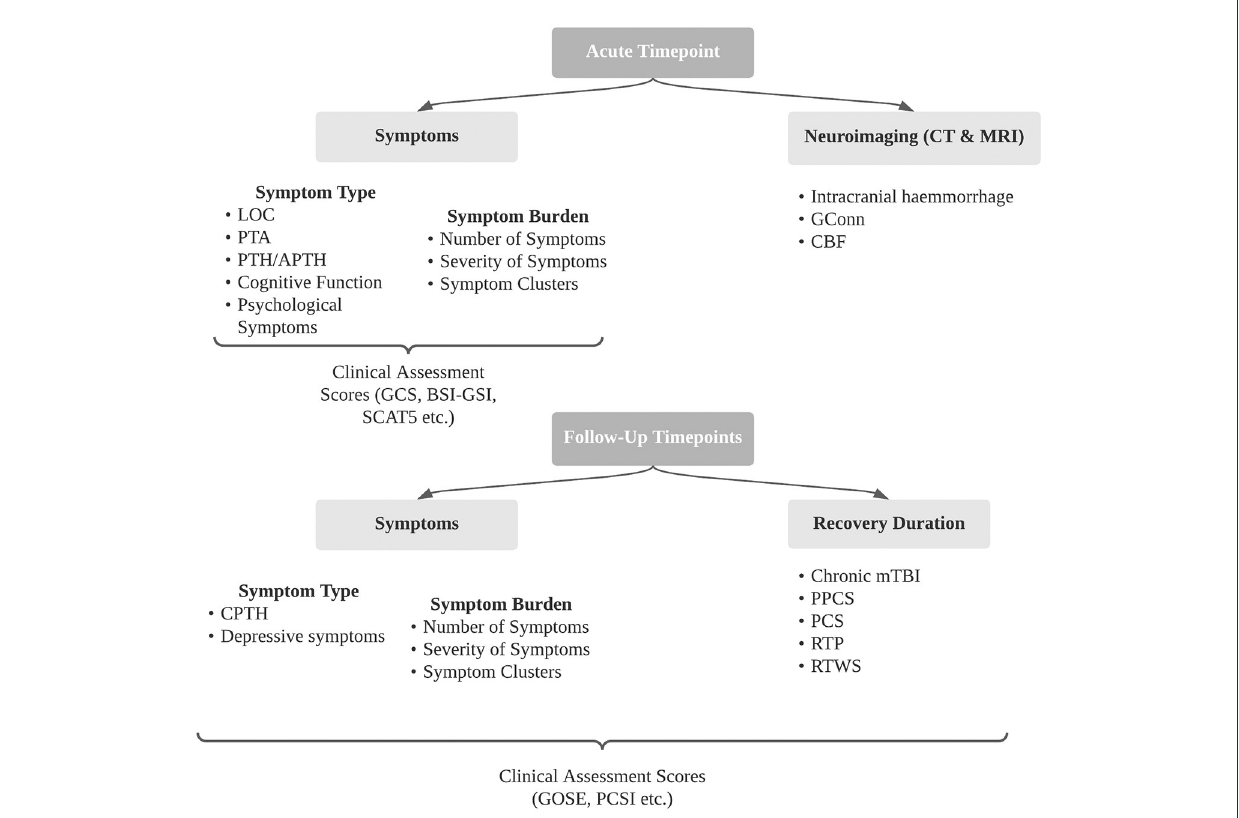
FIGURE2 Summary of secondary outcomes following concussion identified in included studies. BSI- GSI, brief symptom inventory - Global Severity Index; CBF, cerebral blood flow; CPTH, chronic post-traumatic headache; CT, computer tomography; GConn, global connectivity; GCS, Glasgow Coma Scale; GOSE, Glasgow Outcome Scale Extended; LOC, loss of consciousness; PCS, post-concussion syndrome; PCSI, post-concussion symptoms inventory; PPCS, persistent post-concussion symptoms; PTA, post-traumatic amnesia; PTH, post-traumatic headache; RTP, return to play; RTWS, return to work and school; SCAT5, sports concussion assessment tool